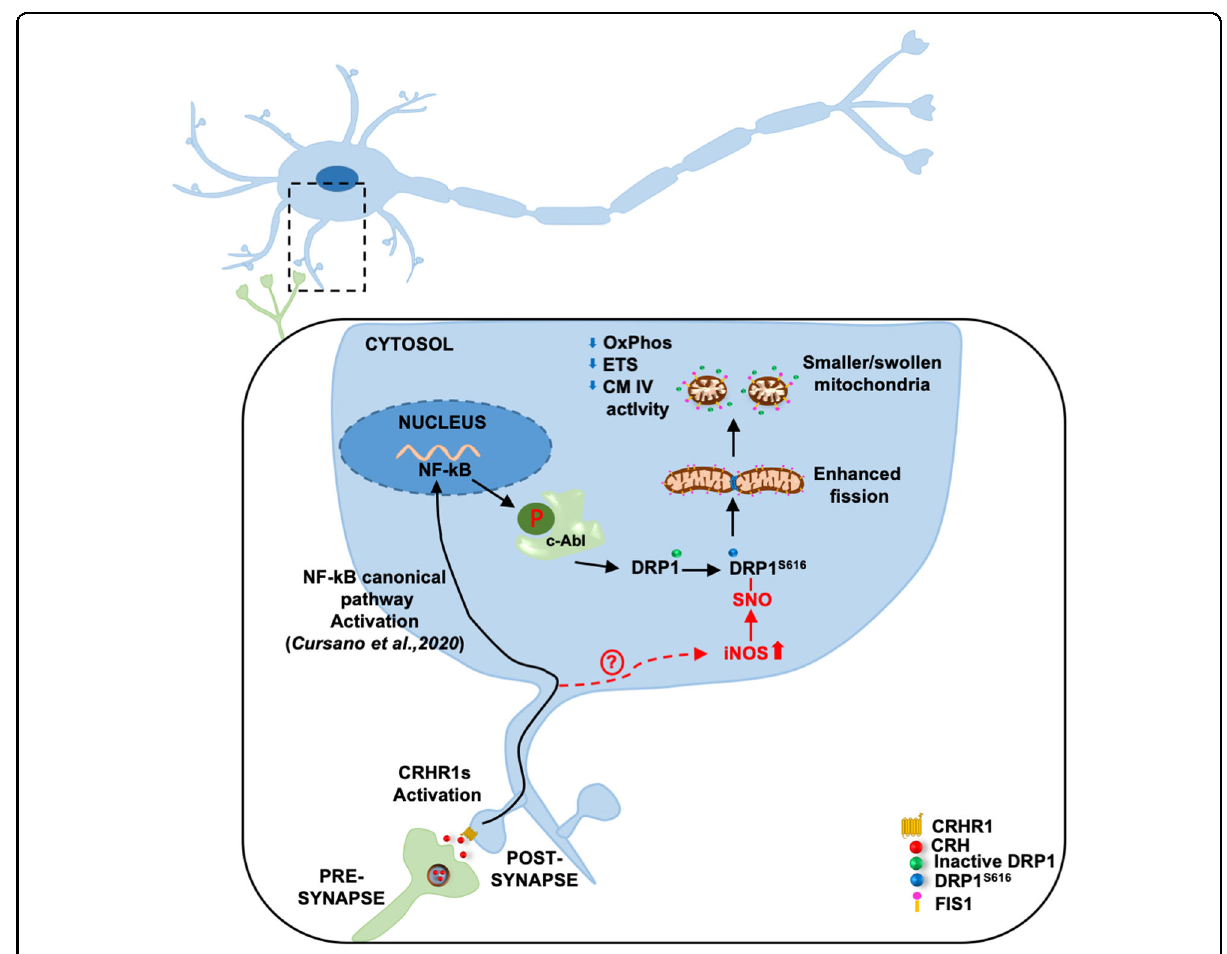
Fig. 9 Schematic representation of the proposed molecular mechanism. CRHR1 activation triggers a signaling cascade leading to the activation of Nf-KB and increased iNOS activity. This eventually leads to increased phospshporylation and nytrosilation of DRP1, which drives the morphological and bioenergetics alterations of mitochondria upon CRH